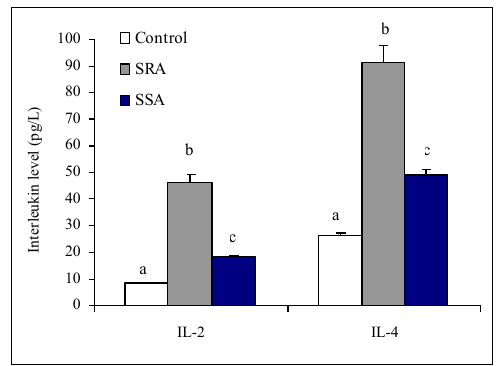
Fig. (3): Interleukins level among SSA (n=28) and SRA (n=27) patients. Values are (mean ± SEM). Non-identical superscripts (a, b, c) considered significant, P<0.05 analyzed by ANOVA. (3). Total WBC counts were significantly high in SRA and SSA in comparison to control group, P<0.05 (P<0.05) as shown in figure (4).